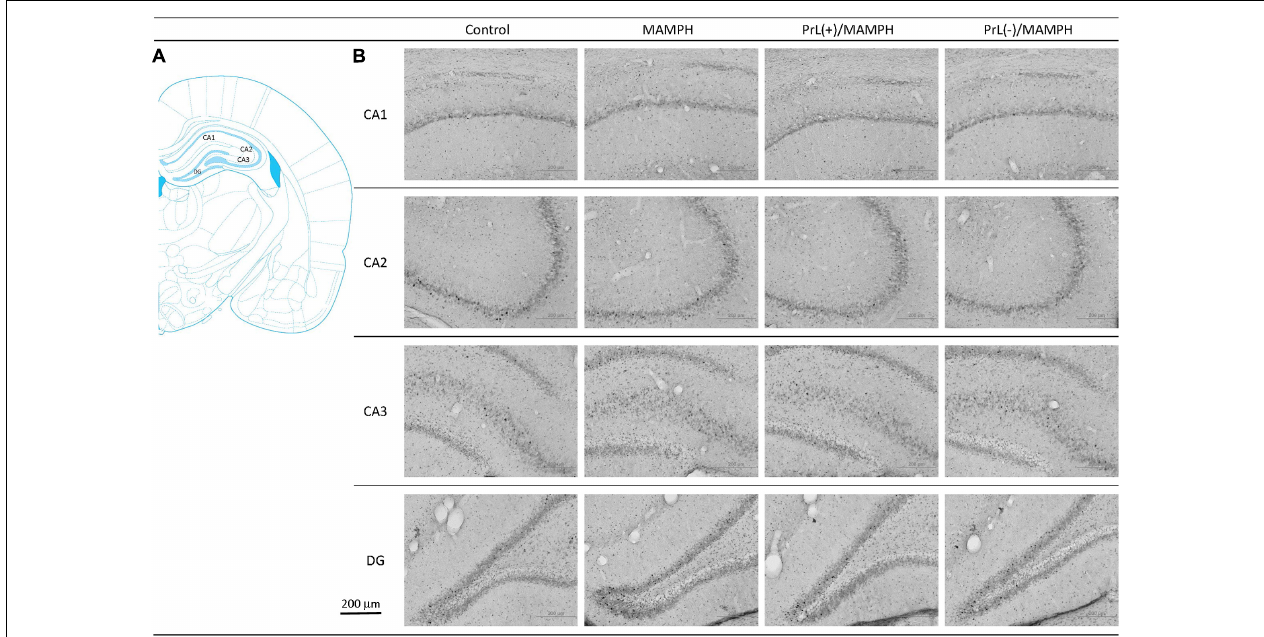
FIGURE 8 | (A) A schematic brain atlas for the CA1, CA2, CA3, and DG of the hippocampus. (B) Representative photomicrographs of c-Fos expression for the CA1, CA2, CA3, and DG of the hippocampus in the control, MAMPH, PrL(+)/MAMPH, and PrL(–)/MAMPH groups. The scale bar represents 200 µ m.